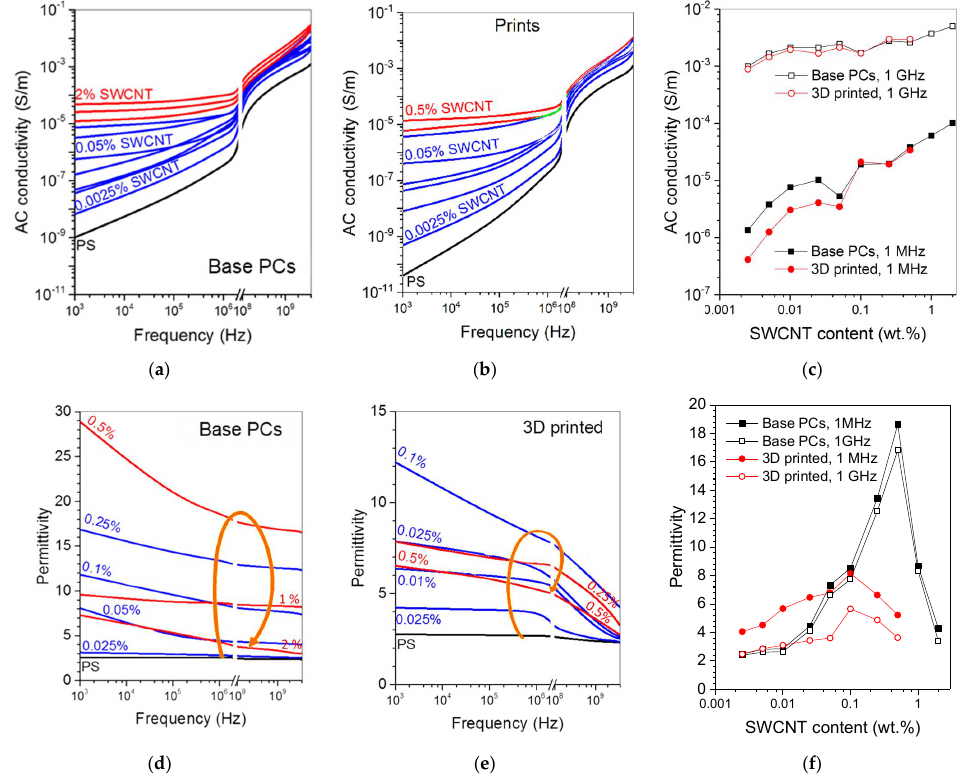
Figure 4. Frequency dependencies of AC conductivity and permittivity of base PC films ( a , d ) and printed samples ( b , e ). Concentration dependencies of the AC conductivity ( c ) and permittivity ( f ) of samples at 1 MHz and 1 GHz. Arrows in ( d , e ) follow the increase in SWCNT content.